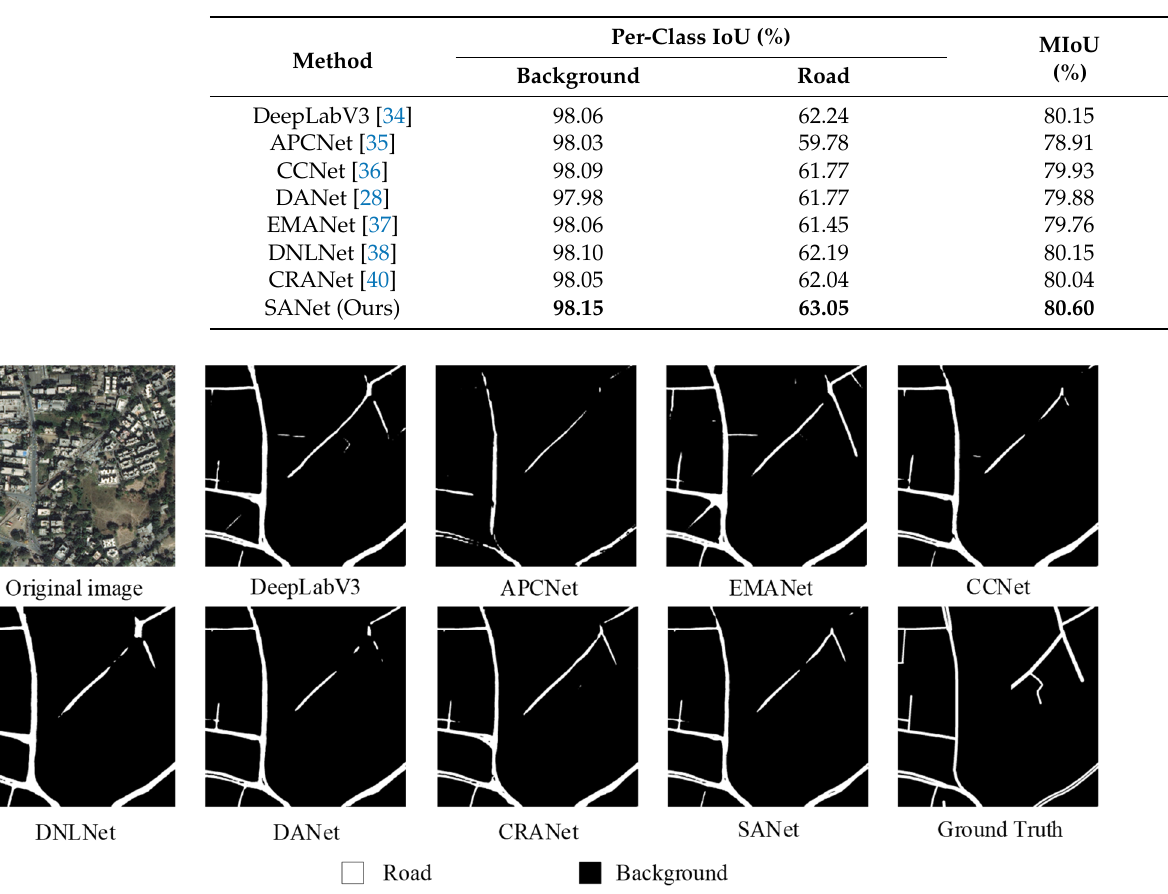
Figure 16. Comparison of visual results of each method based on DeepGlobe dataset.